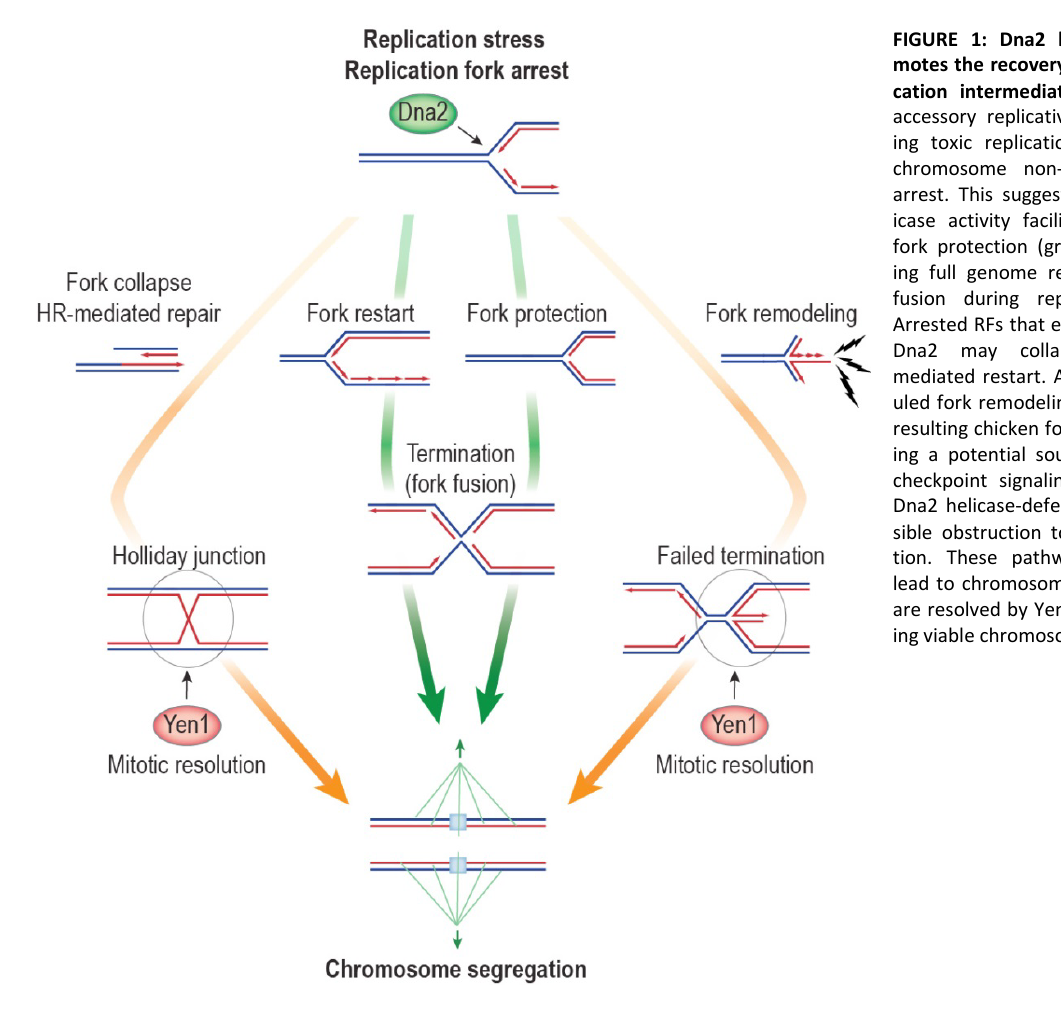
FIGURE 1: Dna2 helicase activity pro- motes the recovery of stalled DNA repli- cation intermediates . Dna2 acts as an accessory replicative helicase, suppress- ing toxic replication intermediates and chromosome non-disjunction after RF arrest. This suggests that the Dna2 hel- icase activity facilitates fork restart or fork protection (green arrows), promot- ing full genome replication and/or fork fusion during replication termination.